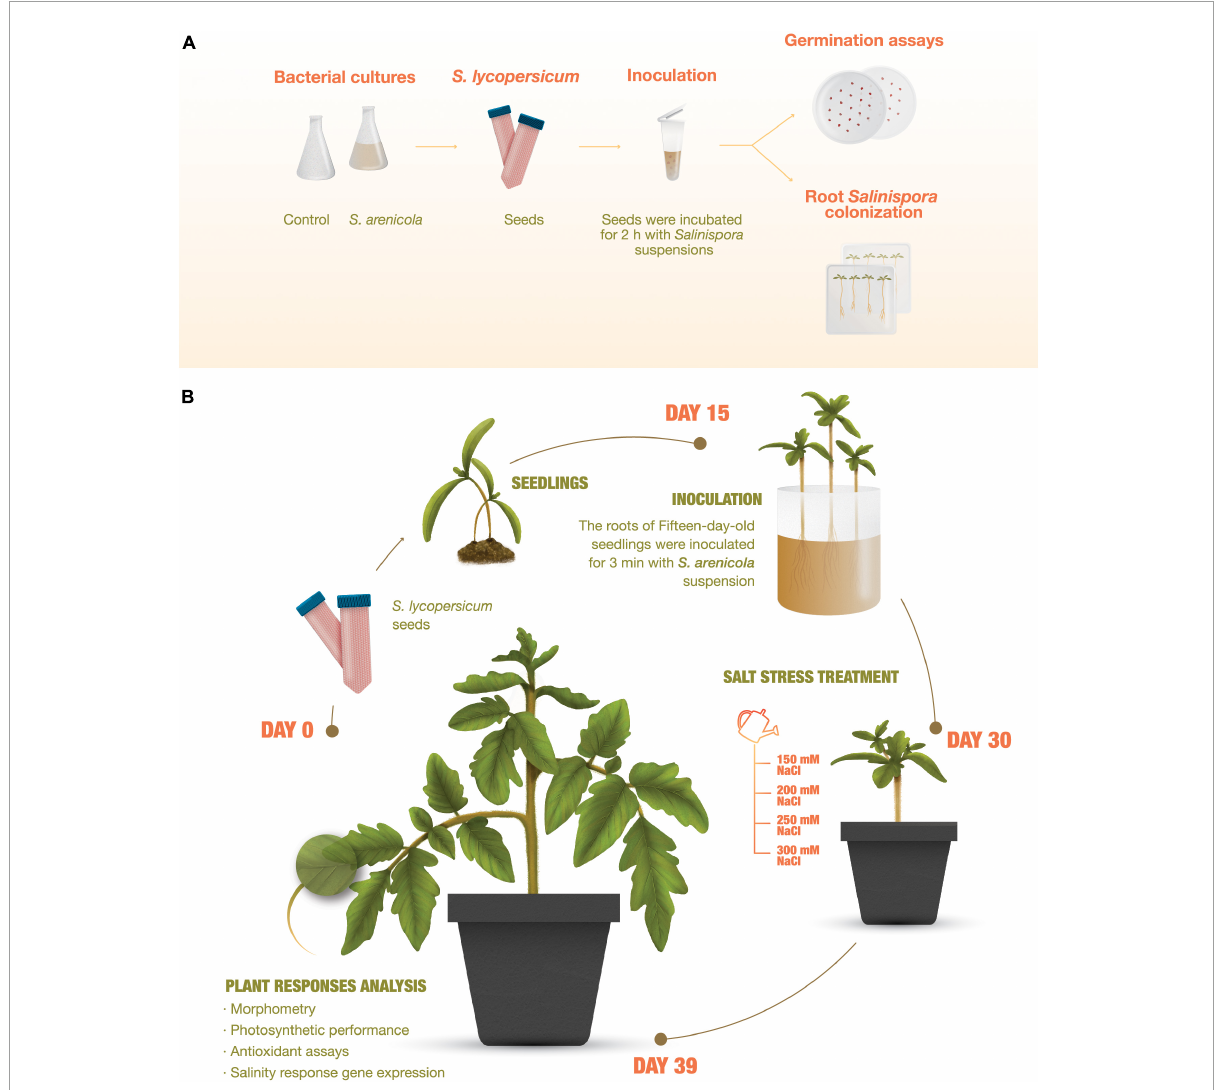
FIGURE1 Experiment outline. (A) Root Salinispora colonization and germination assays of tomato ( Solanum lycopersicum ) plants. Seeds were sterilized, directly inoculated with S. arenicola X29, and sown and cultured in phytagel-agar plates. Growth and plant response analyses. (B) Tomato seedling roots were inoculated on day 15. On day 30, the plants were treated for 8 days with increasing NaCl concentrations and analyzed on day